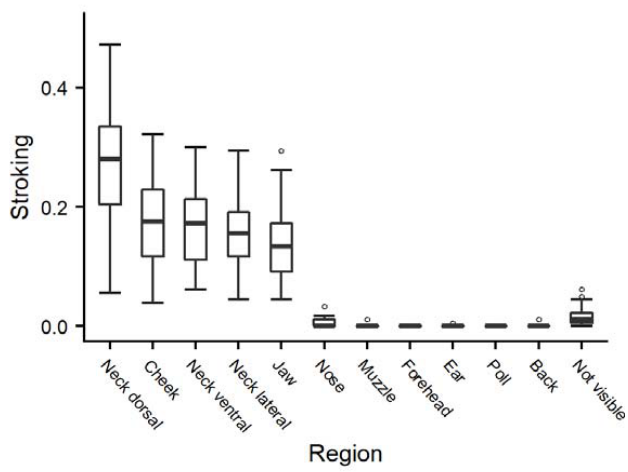
Figure 1. Durations (as a proportion of the total time observed) of stroking for each area of the head/neck region of heifers ( n = 28) in the “reactive” treatment, averaged across the three trials per animal. As behaviours indicating positive a ff ective states, we statistically analysed the behaviours neck stretching 0 (0–180), contact 0 (0–159), eye closed 12 (0–180); Figure 3f: ear flicking 2 (0–68)).